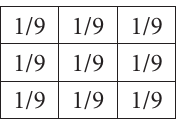
Figure 3.3. 3 × 3 averaging kernel often used in mean